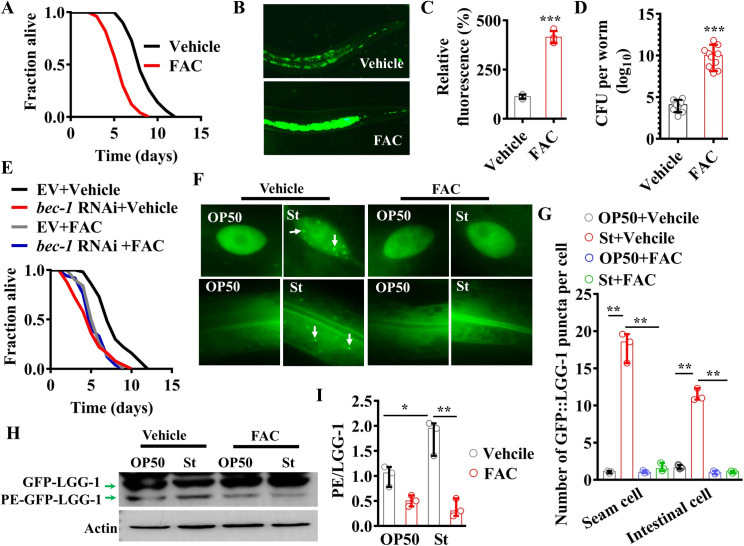
Iron inhibits autophagy induced by S. Typhimurium.(A) Wild-type (WT) worms treated with ferric ammonium citrate (FAC, 100 μM) were more susceptible to killing by S. Typhimurium (St) than those without FAC treatment (vehicle). P< 0.01 relative to vehicle (Log-rank test). Underlying data are available in S1 Table. (B) FAC treatment promoted accumulation of S. Typhimurium. Representative images of WT worms exposed to S. Typhimurium expressing GFP for 48 h. (C) Fluorescence intensity of S. Typhimurium expressing GFP. These results are mean ± SD of four independent experiments performed in triplicate (n = 15 worms per experiment). ***P< 0.001 (two sample t-test). Underlying data are available in S2 Table. (D) Colony-forming units (CFU) of S. Typhimurium were measured in worms. These results are mean ± SD of 10 independent experiments (n ≥ 50 worms per experiment). ***P< 0.001 (two sample t-test). Underlying data are available in S2 Table. (E) The survival of worms subjected to bec-1 RNAi or empty vector (EV) after S. Typhimurium infection in the absence or presence of FAC. P< 0.01 relative to EV+ vehicle. Underlying data are available in S1 Table. (F) Representative images of autophagosomes (GFP::LGG-1 puncta) in the seam cells (upper panels) and intestinal cells (lower panels) of worms exposed to S. Typhimurium or E. coli OP50 for 12 h in the absence or presence of FAC. The arrows denote representative autophagosomes. (G) The numbers of GFP::LGG-1 puncta were counted. These results are mean ± SD of three independent experiments (n = 15 worms per experiment). **P< 0.01 (one-way ANOVA followed by a Student-Newman-Keuls test). Underlying data are available in S2 Table. (H) The protein levels of PE-GFP-LGG-1 to GFP-LGG-1 were measured by Western blot in worms exposed to S. Typhimurium or E. coli OP50 for 12 h in the absence or presence of FAC. The blot shown here is typical of three independent experiments. (I) Quantification of the ratio of PE-GFP-LGG-1 to GFP-LGG-1 from Western blot (H). These results are mean ± SD of three experiments. *P < 0.05, St versus E. coli OP50; **P < 0.01, St+FAC versus St alone (one-way ANOVA followed by a Student-Newman-Keuls test). Underlying data are available in S2 Table.